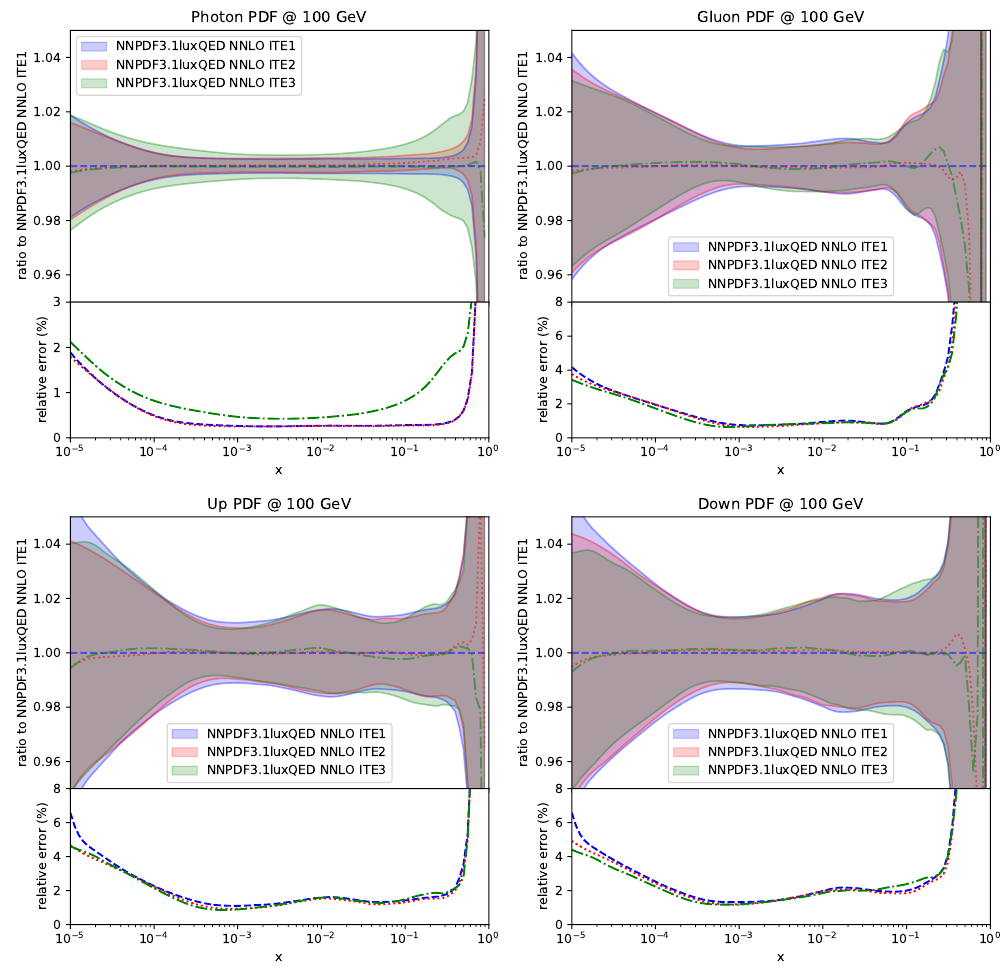
Figure 2.3: Comparison of the photon, gluon, up quark, and down quark PDFs at Q = 100 GeV between the first and second iterations fit (ITE1 and ITE2 respectively) of the fitting procedure sketched in Fig. 2.2. For completeness, we also show the third and final iteration of the procedure n (ITE3) where the additional LUXqed17 systematic variations have been ite added to γ ( x , Q ) , see Sect.